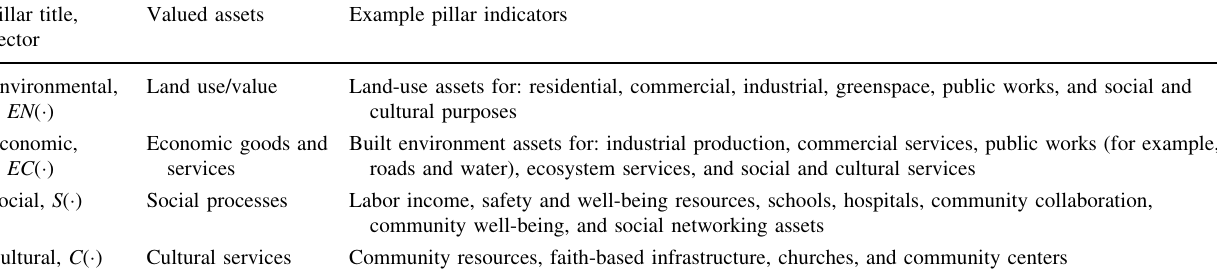
Table 1 Pillars of community sustainability in Canadian municipalities